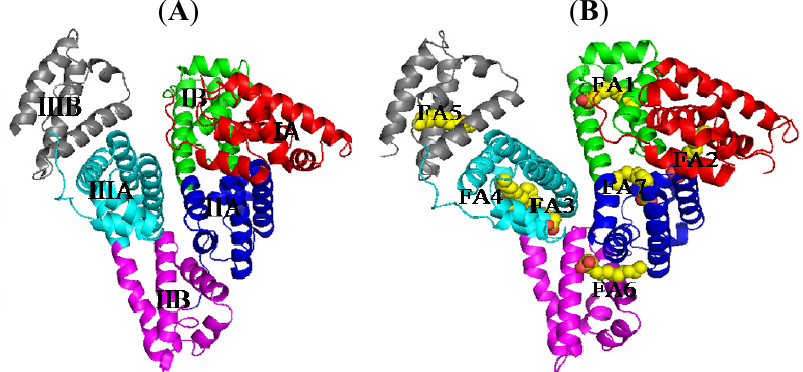
Figure 1. The overall structures of human serum albumin (HSA) ( A ) and HSA–fatty acids (FA) ( B ). Carbon atoms of FA molecule are shown in yellow; oxygen in red; nitrogen in blue; domain IA, in red; domain IB, in green; domain IIA, in blue; domain IIB, in magenta; domain IIIA, in cyan; domain IIIB, in